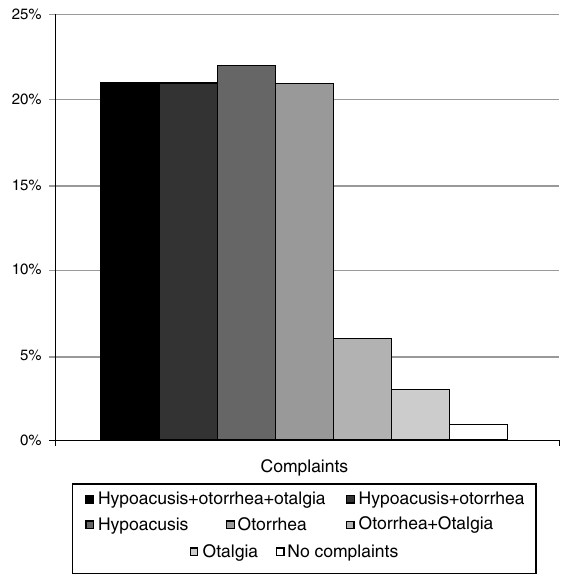
Figure 2 Frequency of the principle complaints of patients with cholesteatoma at the time of first evaluation.